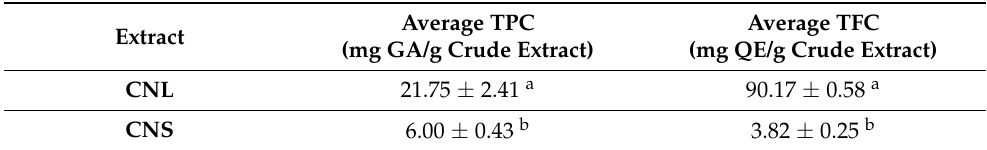
Table 1. Total phenolic content (TPC) and total flavonoid content (TFC) of Clinacanthus nutans leaf (CNL) and stem (CNS) methanolic extracts.